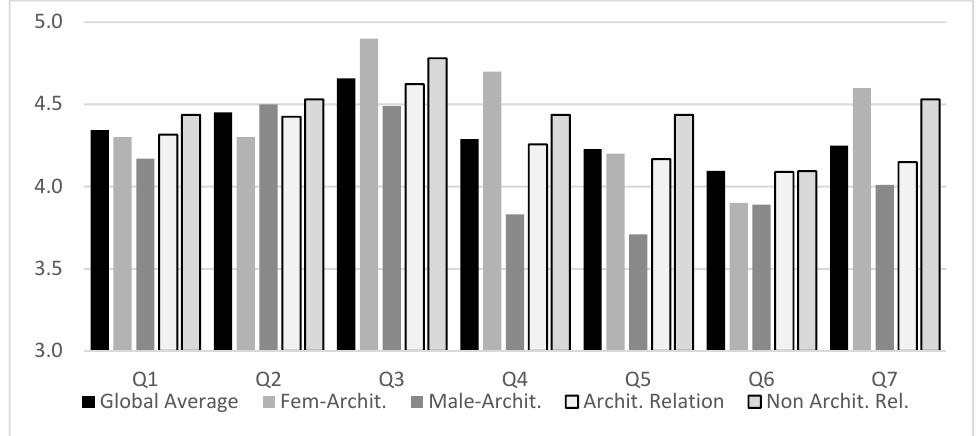
Figure 10. Q1–Q7 Results: Global average by gender related to architectural activities and comparison between non-architectural and architectural professionals.